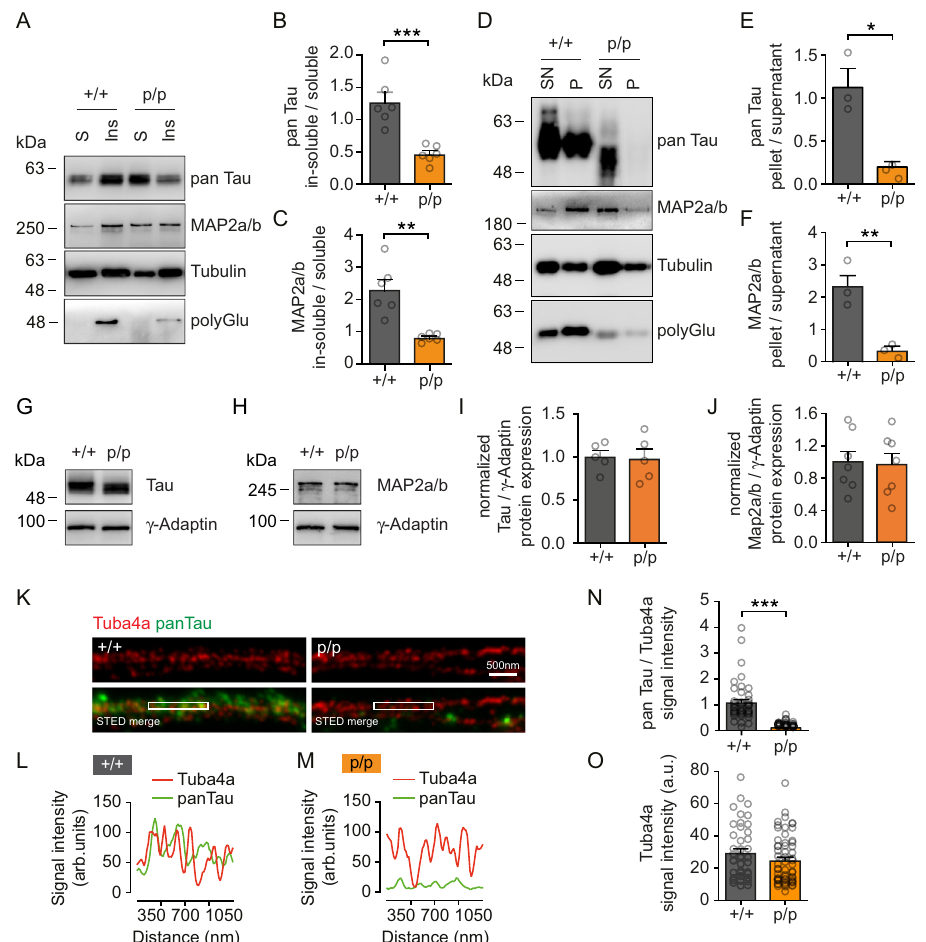
Fig. 4 Loss of Tuba4a C-terminal polyglutamylation signi fi cantly decreases Tau binding to microtubules. A – C Soluble-tubulin extraction assay using DIV15 neurons derived from Tuba4a Δ polyGlu ( + / + ) and (p/p) mice. A Western blot. Soluble fraction (S): un-polymerized tubulin and dissociated MAPs. Insoluble fraction (Ins): polymerized tubulin (microtubules) and associated MAPs. Fractions were probed for pan Tau, MAP2a/b, total alpha-tubulin, and polyglutamylated tubulin (polyGlu). Quanti fi cation of pan Tau ( B ) and MAP2a/b (C) in-soluble/soluble levels. Ratios smaller than 1 indicate higher protein abundance in the soluble fraction. n = 6 independent cultures per genotype. D – F Microtubule pelleting assay after repolymerization of hippocampal tubulin derived from adult mice. D Western blot. Supernatant (SN): un-polymerized tubulin and dissociated MAPs. Pellet (P): polymerized tubulin (microtubules) and associated MAPs. Fractions were probed for pan Tau, MAP2a/b, total alpha-tubulin and polyGlu. Quanti fi cation of pan Tau ( E ) and MAP2a/b ( F ) pellet/supernatant levels. Ratios smaller than 1 indicate higher protein abundance in the supernatant fraction. n = 3 mice per genotype. G – J Representative western blot analysis depicting Tau ( G ) and MAP2a/b ( H ) normalized to γ -Adaptin protein expression levels in the hippocampus. Respective quanti fi cations are shown in ( I , J ). ( + / + ) set to 1. n = 5 – 7 experiments. K Representative super-resolution STED images of microtubules in axonal regions from DIV14 hippocampal neurons, derived from three independent experiments. Tuba4a (red), pan Tau (green). L , M Line scans: relative intensities of signals along 1 μ m of microtubule length (boxed regions in ( K )). Scale bar, 500 nm. Arbitrary units (arb. units). N Mean pan Tau signal intensities normalized to Tuba4a. n = 45( + / + ), 60(p/p) axonal regions. O Total Tuba4a signal intensities. n = 45( + / + ), 60(p/p) axonal regions. Two-sided unpaired Student´s t-test ( B , C , E , F , I , J ) and Mann – Whitney test ( N , O ) were used to assess statistical signi fi cance. * p < 0.05, ** p < 0.01, *** p <